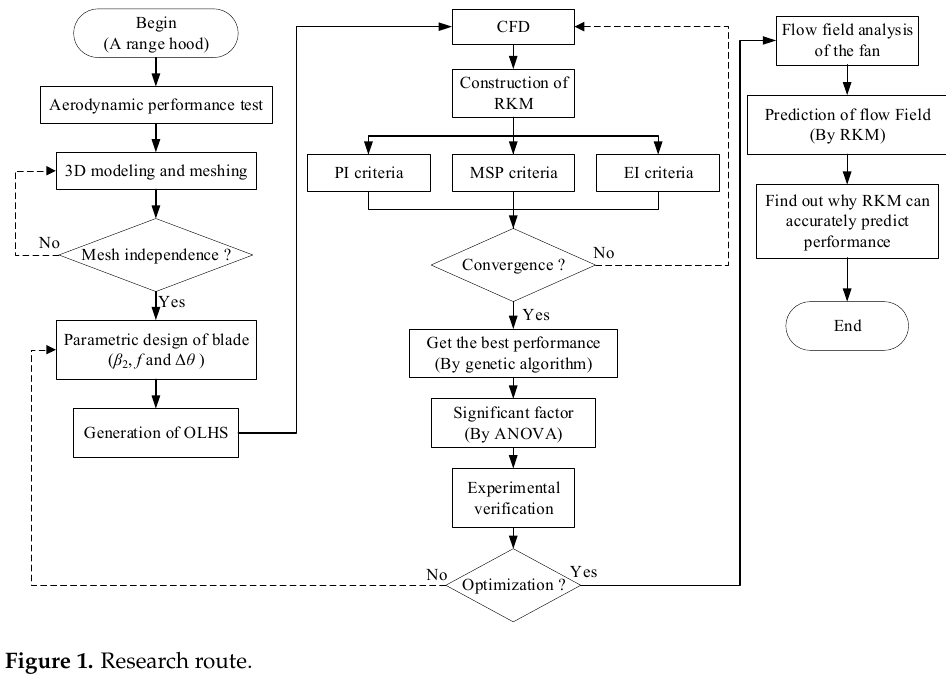
Figure 1. Research